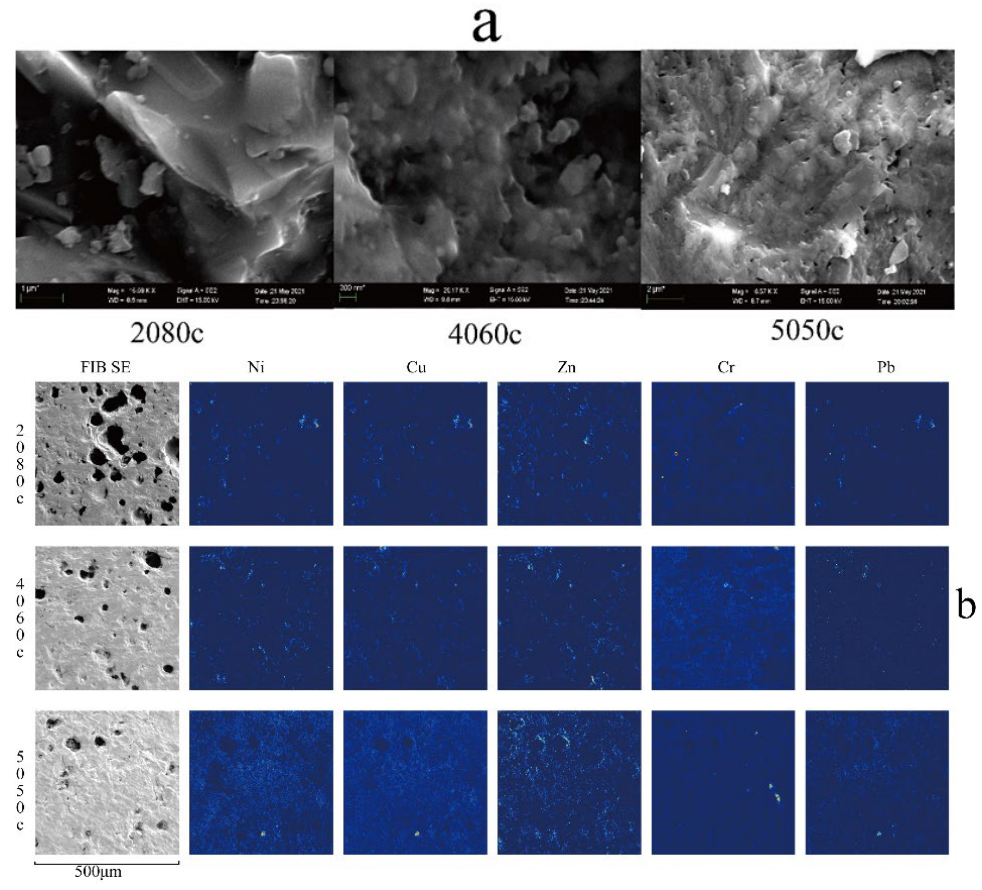
Figure 4. ( a ) SEM micrographs and ( b ) FIB-SIMS images of the glass ceramic samples.